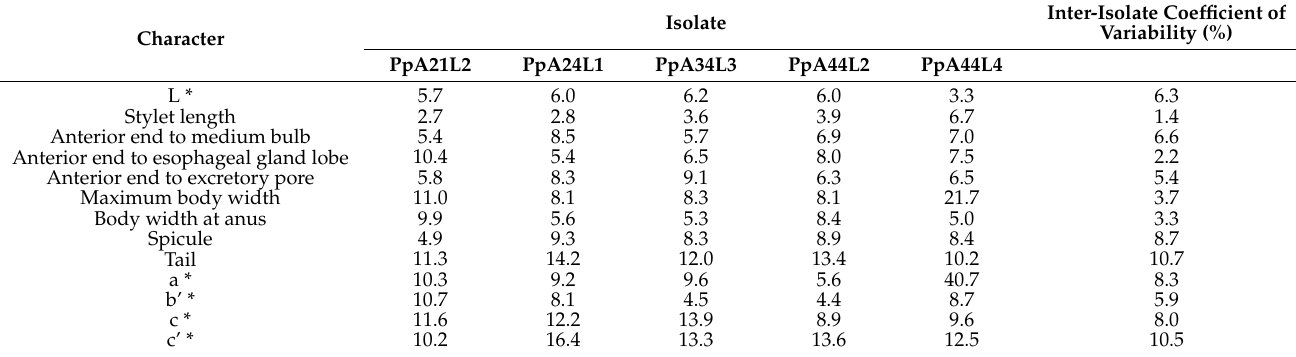
the anus. Table 4. Intra- and inter-isolate coefficient of variability (%) of Pratylenchus penetrans males from Portugal. Character